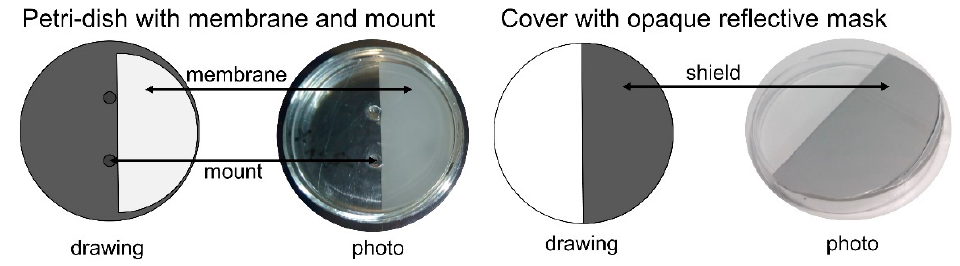
Figure 1. Experimental setup for experiments with shielded PVDF. The adsorbent was placed in the petri-dish and is held in place by glass mounts. A cover that is half-coated with an opaque reflective foil was placed in a way that the adsorbent was either shielded or irradiated.